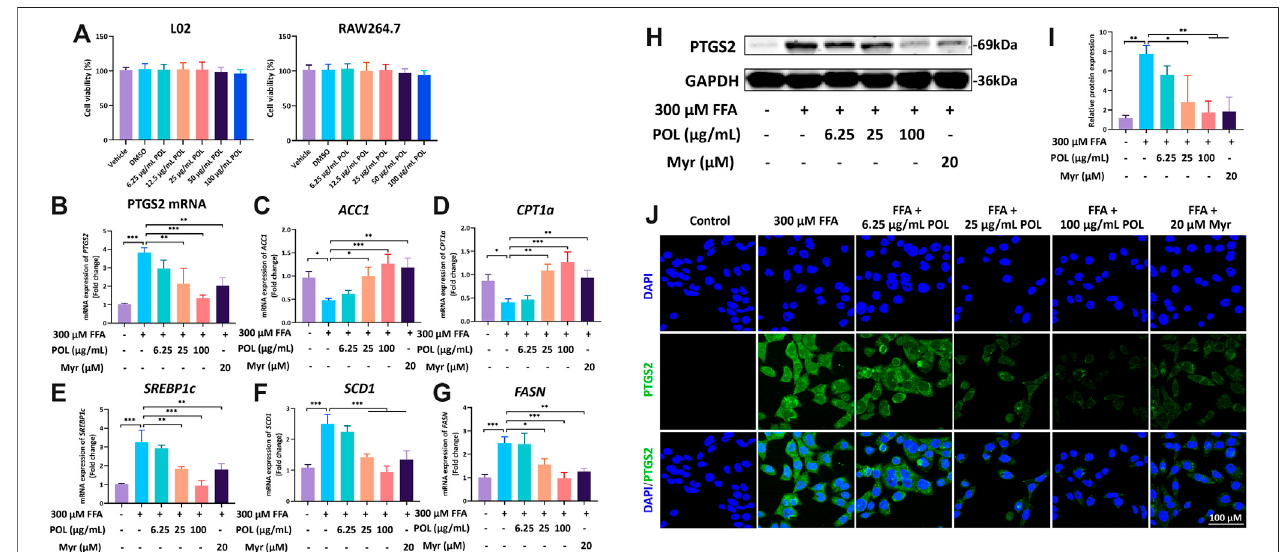
FIGURE8| Theeffects ofPOL and Myronthe protein and mRNAexpression ofPTGS2 and themRNA expression of CPT1a , FASN , SCD1 , ACC1 ,and SREBP1c in FFA-induced L02. L02 cells were incubated with 300 μ M FFA (oleic acid: palmitic acid (cid:1) 2: 1) and treated with 6.25, 25, and 100 μ g/ml POL and 20 μ M Myr for 24 h, respectively. (A) Cell viabilities ofL02 and RAW264.7treated with 6.25, 25, and 100 μ g/ml POL. The mRNA expression of PTGS2 (B) , ACC1 (C) , CPT1a (D) , SREBP1c (E) , SCD1 (F) , and FASN (G) were determined by qt-PCR. Then, the protein expression of PTGS2 was detected by western blot (H) and immuno fl urescence staining (I) and. The relative protein expression of PTGS2 was calculated (J) . Comparing with model group, * p < 0.05, ** p < 0.01, *** p < 0.001.